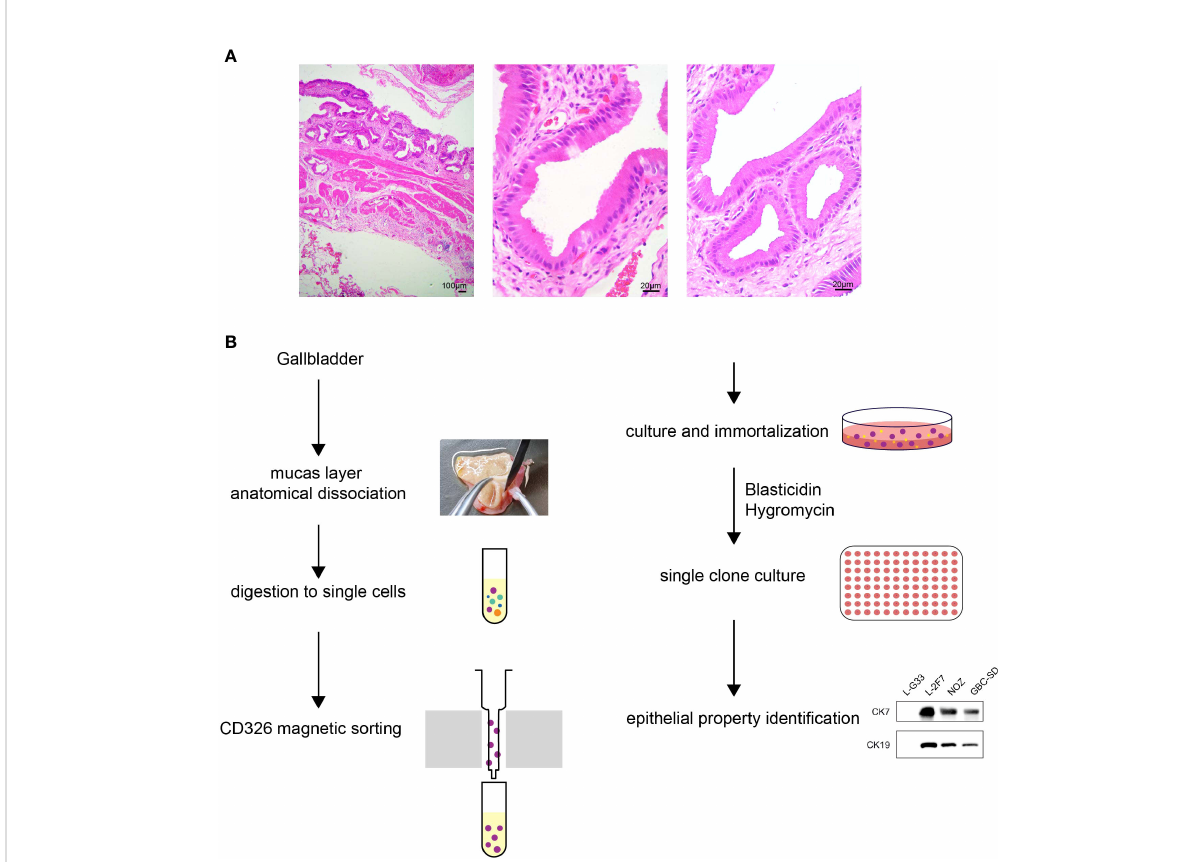
FIGURE 1 Pathology of gallbladder tissue and the scheme of L-2F7 cell line establishment. Partial fragments of original gallbladder tissues were used for isolating epithelial cells in HE staining, which showed no signi fi cant pathological abnormality of gallbladder (A) . Gallbladders were collected after the surgical operation and its mucosa layers were then dissociated anatomically. After being digested into single cells, CD326-positive cells were collected using magnetic cell sorting. The primary epithelial cells were plated to culture dishes, immortalized, and cultured in the presence of 200 m g/ml blasticidin and 10 m g/ml hygromycin. Limited dilution assays were employed to select clones for the following further characterization (B)